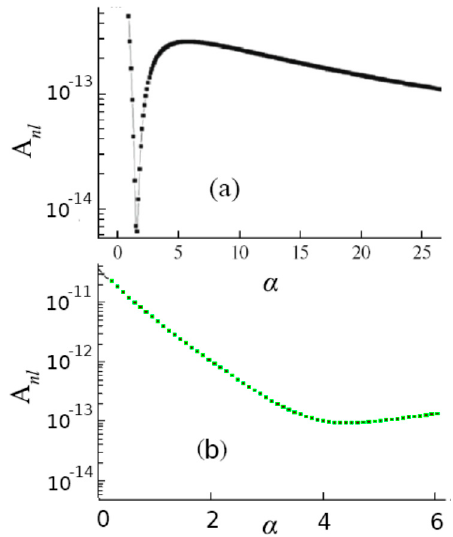
Figure 2. ( a ) Natural width A nl of Rydberg state of s -series ( l = 0) with n = 30 as a function of parameter α of Sommerfeld’s atom. ( b ) The same for the state of p-series ( l = 1) with n = 25. The Förster resonance corresponds to the value α p , s = 2.81.